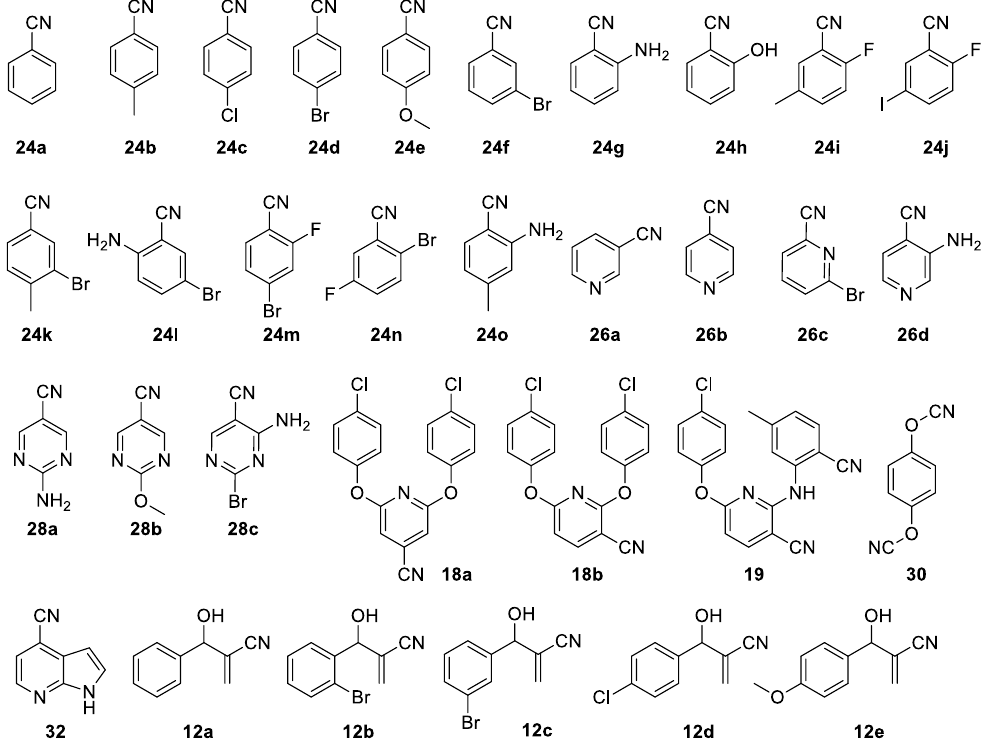
Figure 1. Compounds showing 50% to 100%